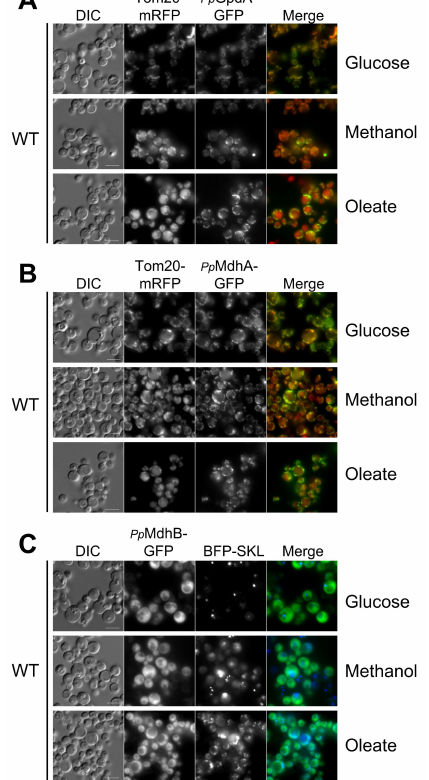
Figure 1. Localization of P. pastoris NADH-shuttling proteins fused with GFP. Fluorescence mi- croscopy of strains grown in glucose, methanol, and oleate overnight. GFP was fused to the C-terminus of the NADH shuttling proteins, and the fusion proteins were expressed from their endogenous promoters. ( A ) Wild-type cells expressing PpGpdA-GFP, ( B ) Wild-type cells expressing PpMdhA-GFP, and ( C ) Wild-type cells expressing PpMdhB-GFP. Colocalization with the mitochon- dria and peroxisomes was observed with Tom20-mRFP or BFP-SKL as mitochondrial and peroxisomal markers, respectively. Bars: 5 µ